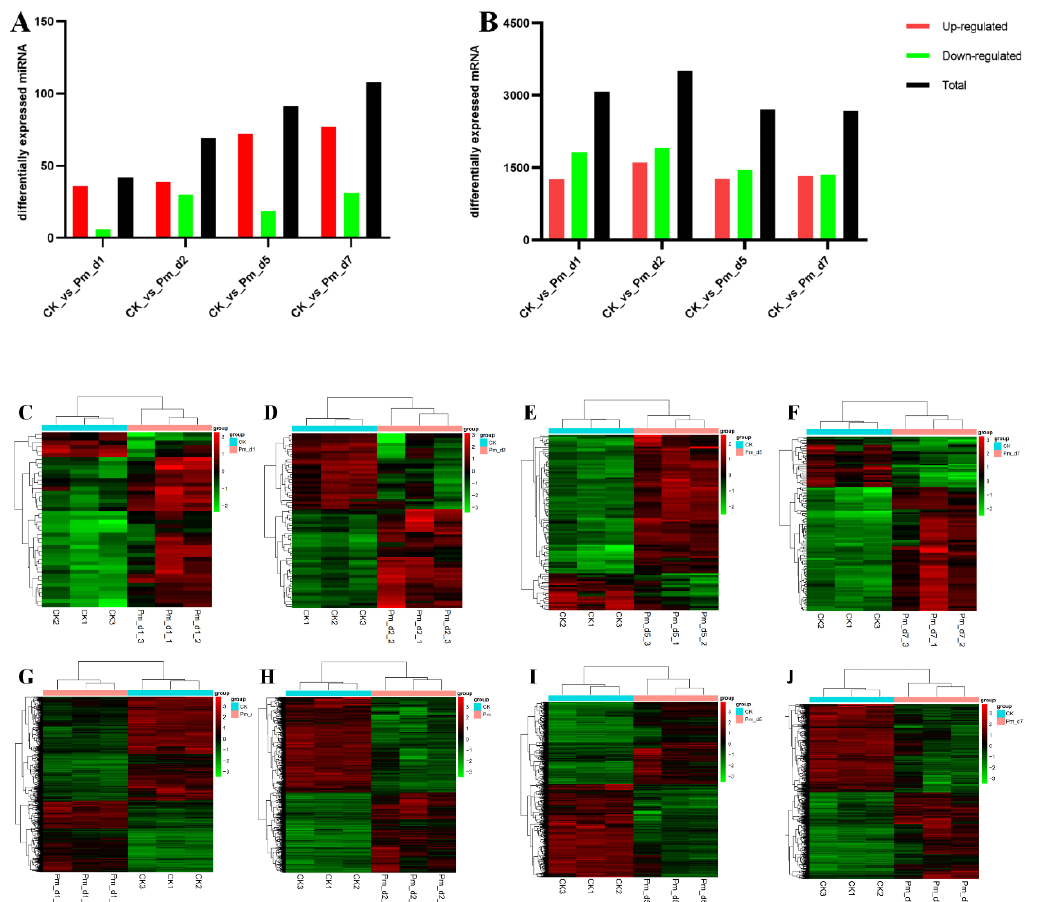
Figure 4. Differentially expressed miRNA and mRNA in the lung tissues of Pm–challenged goats compared with the CK group. ( A , B ) Numbers of differentially–expressed miRNA and mRNA molecules. ( C – J ) Hierarchical clustering analysis heatmap of the differentially-expressed miRNA and mRNA molecules in the Pm infected group compared with the CK group, respectively. CK_vs_Pm_d1, CK_vs_Pm_d2, CK_vs_Pm_d5 and CK_vs_Pm_d7 indicate the goats infected with Pm compared to CK group 1 day, 2 days, 5 days and 7 days after Pm infection,